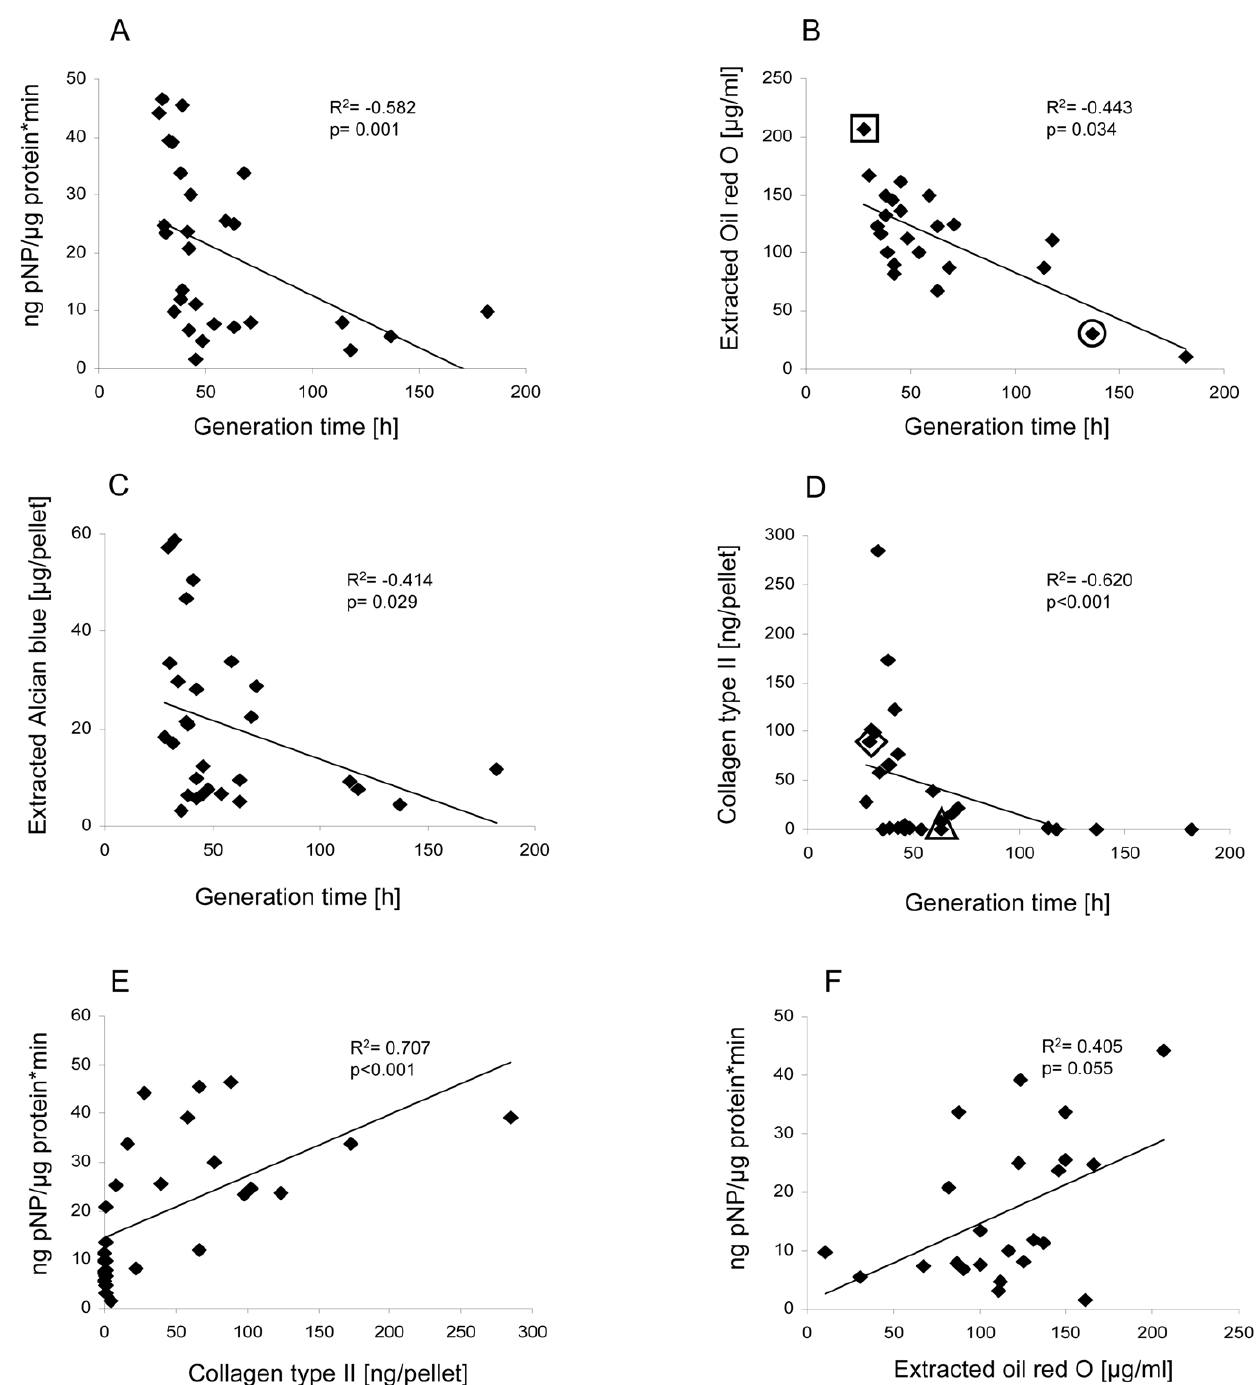
Figure 5. Correlation of proliferation rate and differentiation capacity. (A) Osteogenic and (B) adipogenic differentiation of MSC (passage 3) were induced for 21 days in monolayer. (A) ALP enzyme activity and (B) amount of extracted Oil Red O dye were plotted against generation time of the expanded cells at start of differentiation. (C,D) Proteoglycan and collagen type II deposition of high density pellets were plotted against generation time of the expanded cells at start of differentiation. All four differentiation parameters showed a significant negative correlation with generation time suggesting a reduced differentiation capacity of more slowly growing cells. (E) Chondrogenic differentiation capacity (collagen type II deposition) revealed a strong positive correlation with osteogenic differentiation capacity (ALP activity). (F) Additionally a trend for better adipogenesis (Oil Red O staining) at enhanced osteogenesis (ALP actitivity) almost reached significance. Correlation was calculated by Spearman-Rho Test and p , 0.05 was considered as statistically significant. % donor a in Fig. 3A, q donor b in Fig. 3A, e donor c in Fig. 4A, n donor e in Fig. 4A.